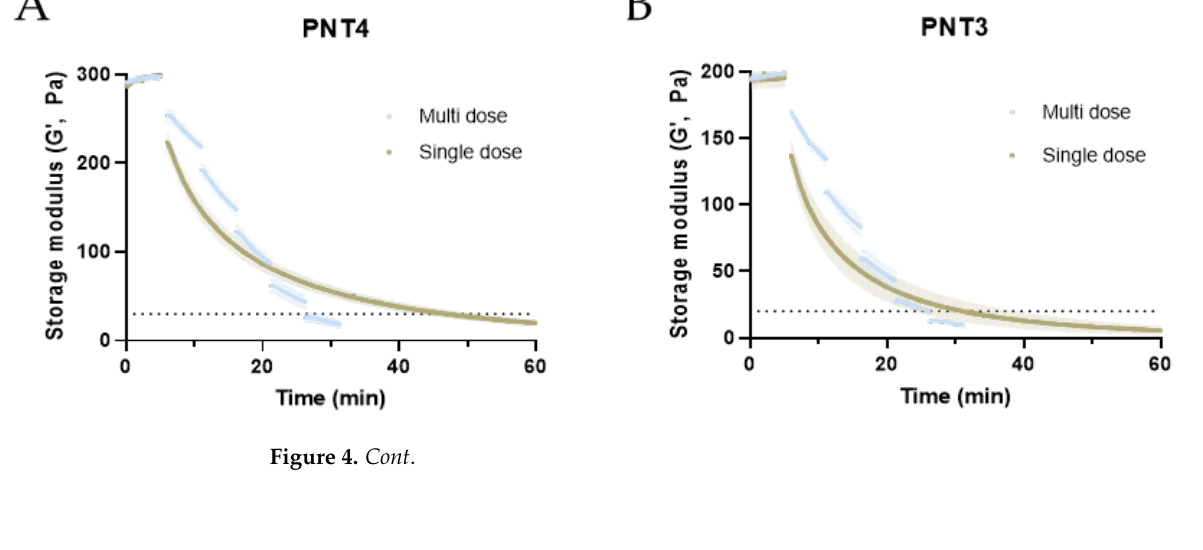
Figure 4. Optimization of PNT4 and PNT3 degradation by multiple injections of 38.3 U · mL − 1 Hylenex every 5 min, followed by rheological time sweeps. Evolution of the storage modulus of PNT4 ( A ) and PNT3 ( B ) gels over time, measured by time sweeps (37 °C, strain 0.1%, 1 Hz) following single or multiple injections of the Hylenex enzyme (38.3 U · mL − 1 per injection, 5 min injection span for multidose), total volume and enzymatic units were equivalent to single and multidose. Dotted lines represent 10% of initial G’, First derivative curves of PNT4 ( C ) and PNT3 ( D ) gels for single and multidose injections, area under the curve of PNT4 ( E ) and PNT3 ( G ) gels calculated from the first derivative curves, time required to reach 90% of gel degradation for PNT4 ( F ) and PNT3 ( H ) gels, relative to the initial storage modulus. All results are presented as mean ± S.D, n = 3. 3. Materials and Methods 3.1. Materials The investigated HA-based soft-tissue fillers were selected from the TEOSYAL RHA ® collection and are displayed in Table 1. Hylenex, a human recombinant hyaluronidase (150 USP U·mL −1 , Halozyme Therapeutics, San Diego, CA, USA) and Hyalase (powder from ovine origin, Hyaluronidase 1500 I.U, Wockhardt, UK) were used for the rheological